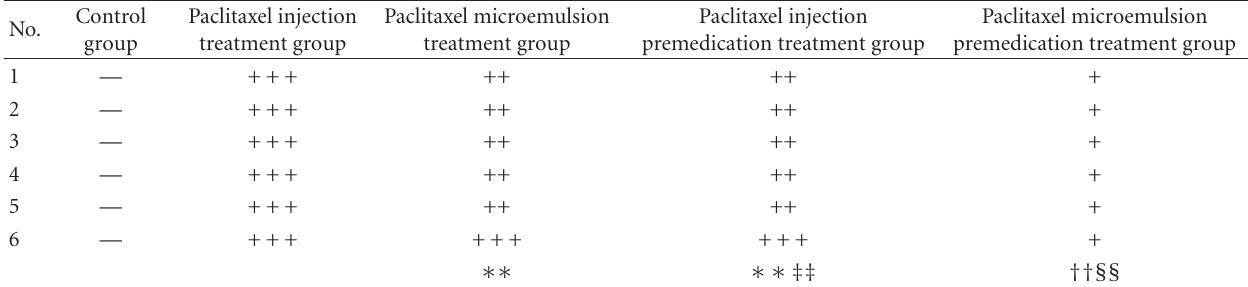
Table 4: The rank of allergic reactions for each